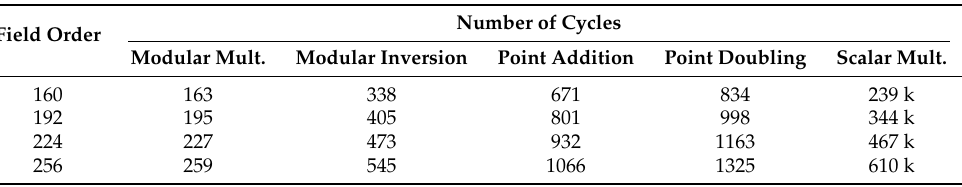
Table 2. Execution cycles for different operations.